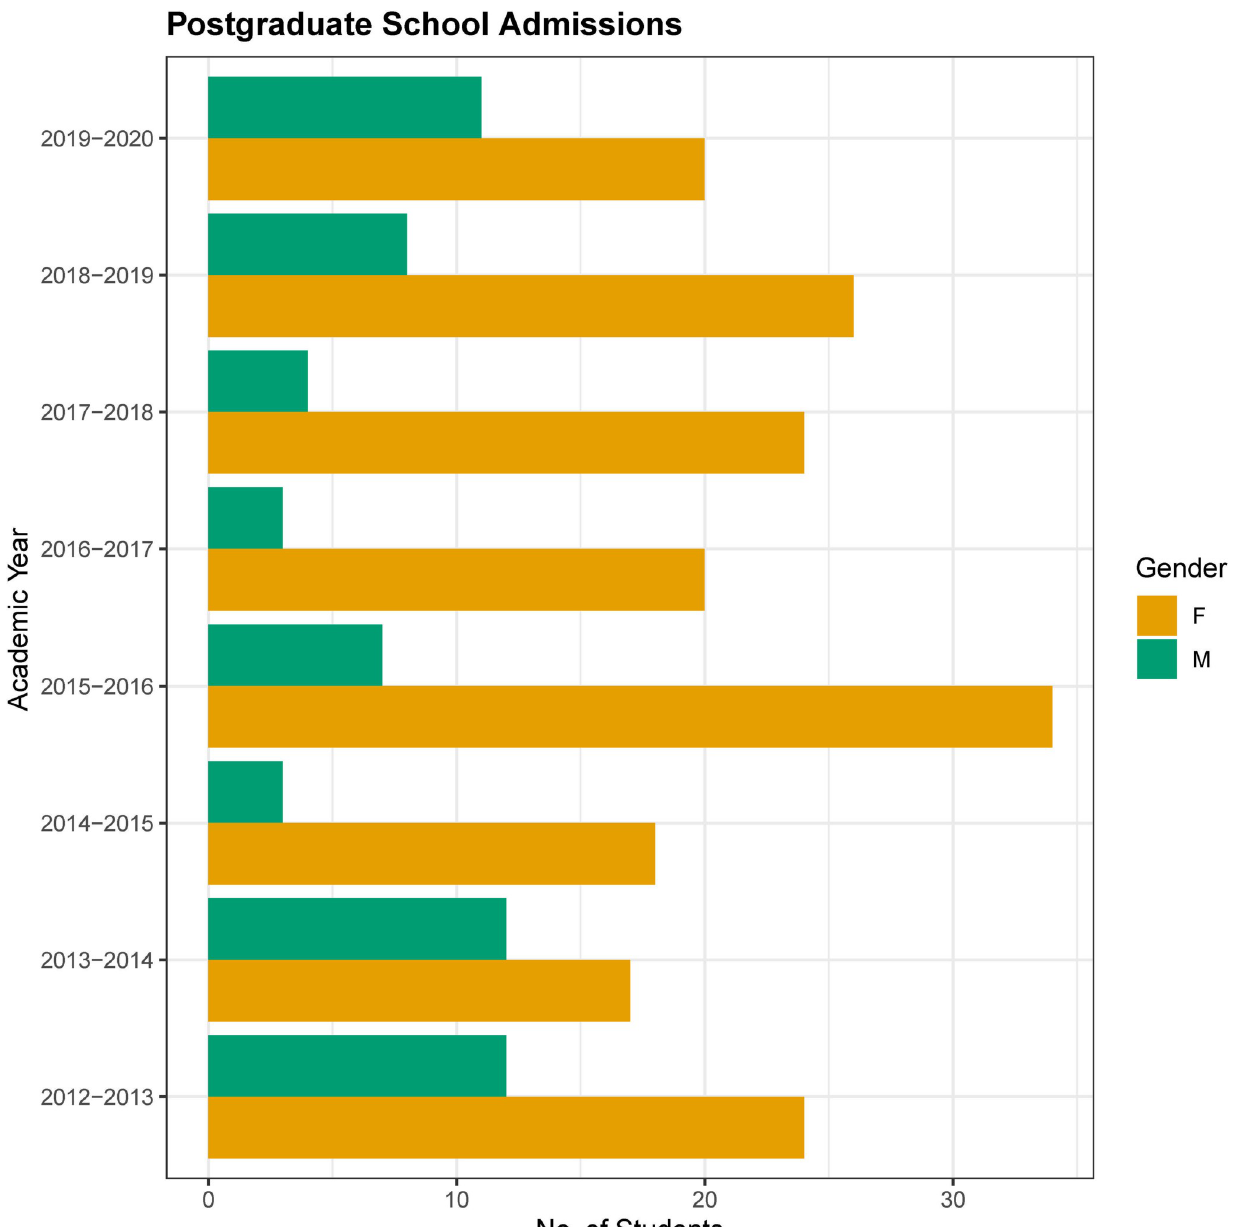
Fig 4. Successive academic year postgraduate student gender representation. Histogram of the percentage of female and male students recruited in across 8 consecutive academic years.